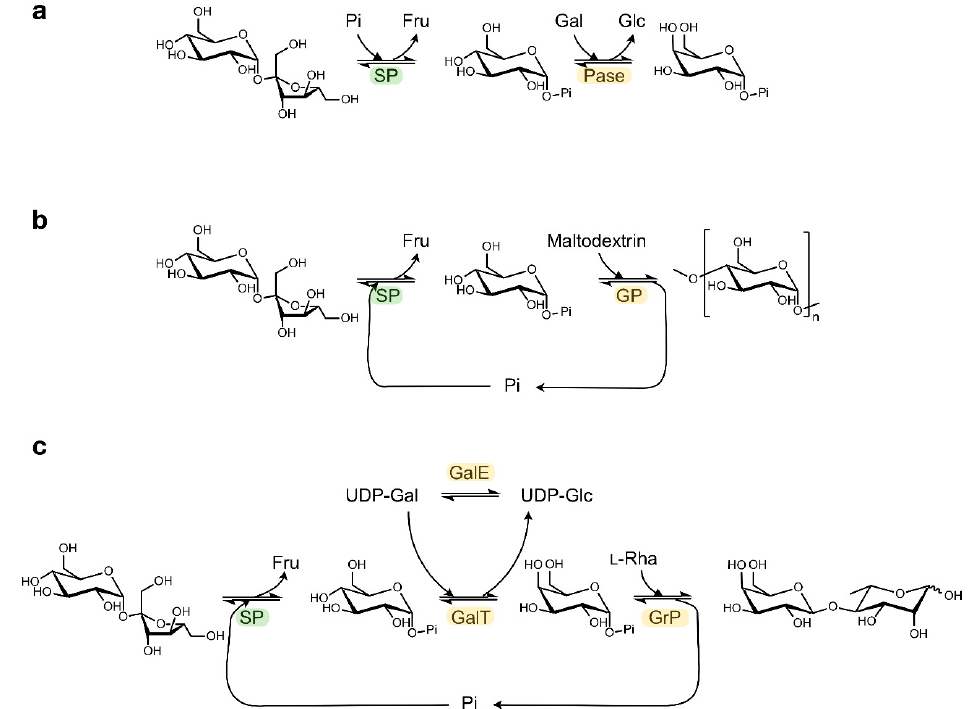
Figure 3. Examples of cascade reactions with SP. Synthesis of ( a ) α -galactose 1-phosphate, ( b ) amylose, ( c ) β (1,4)-Galactosyl l -rhamnose. (Pi: phosphate; Fru: fructose; Glc: glucose; Gal: galactose; Rha: rhamnose; Pase: α -glucose 1-phosphatase; GP: α -glucan phosphorylase; GalT: UDP-glucose—hexose 1-phosphate uridylyltransferase; GalE: UDP-glucose 4-epimerase; GrP: β (1,4)-Galactosyl l -rhamnose